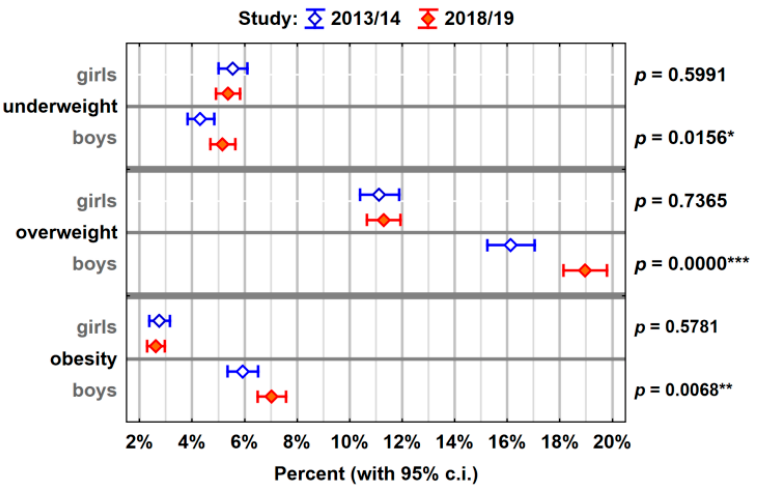
Figure 1. A comparison between the prevalence of underweight, overweight, or obesity in both studies among girls and boys. ( p < 0.05 (*), p < 0.01 (**), p < 0.001 (***)).